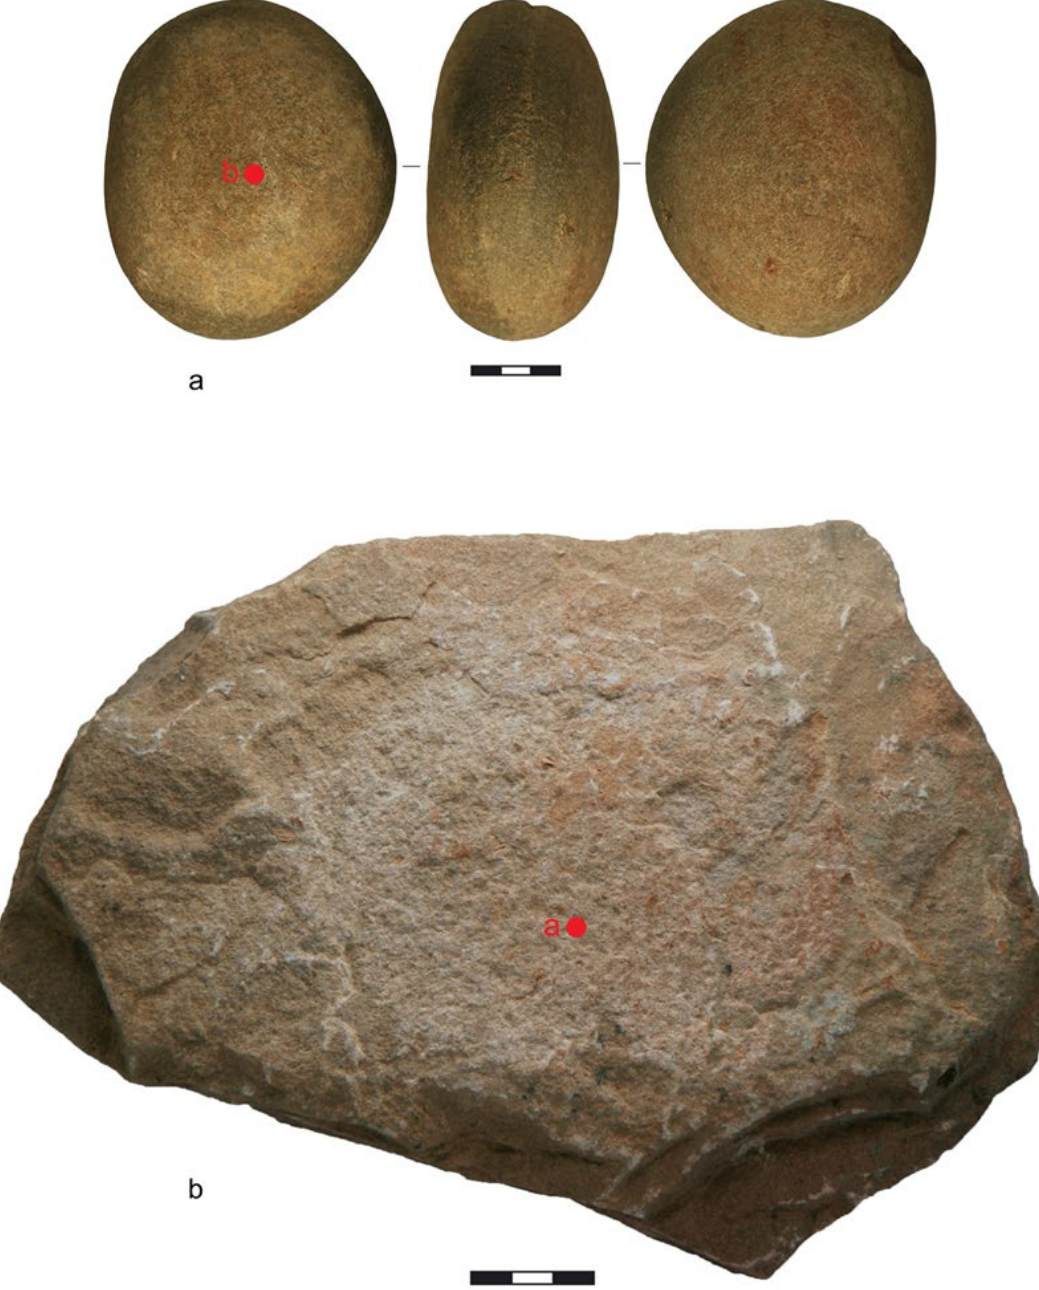
Figure 7. Experimental tools for grinding dried cattail roots after the end of an experiment: a - mano; b - grinding stone (scale bar = 1 cm). The red spot indicates the location from which the micro-photo was taken (see Figure